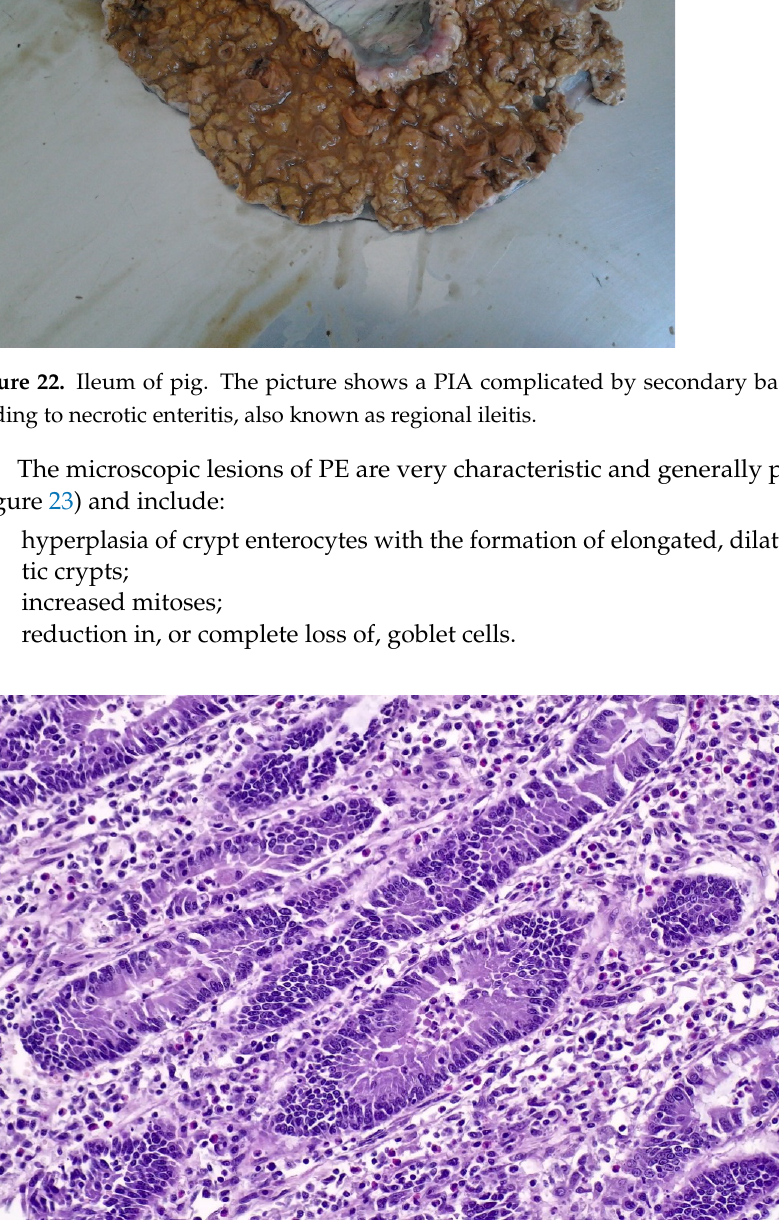
Figure 23. Ileum of pig affected by PE shows a hyperplastic epithelium of crypts (Haematoxylin and Eosin stain;